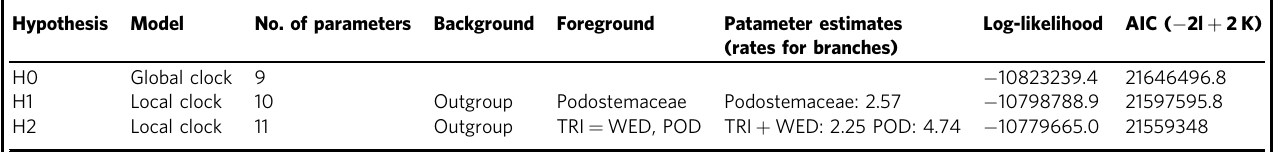
Table 1 Results of relative-rate test using Global and Local clock models in PAML. Hypothesis